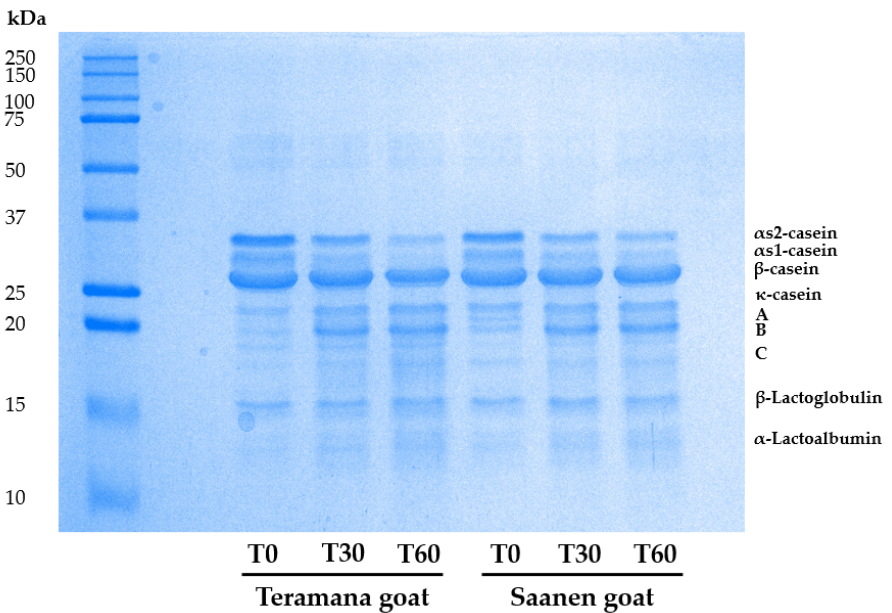
Table 2. Chemical composition of cheese at 0 (T0), 30 (T30), and 60 (T60) days of ripening, obtained from the milk of two goat breeds: Teramana and Saanen.